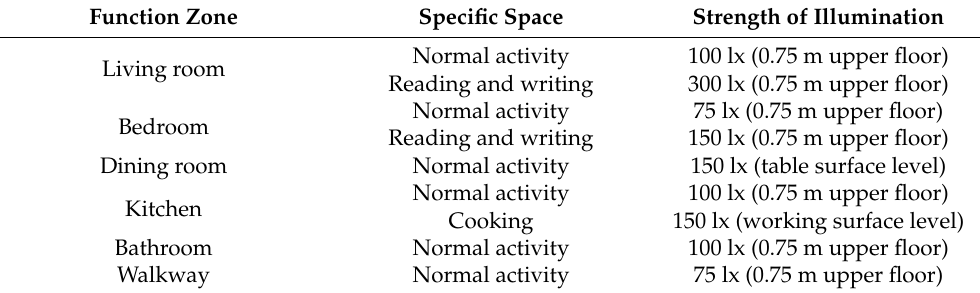
Table 3. Lighting environment